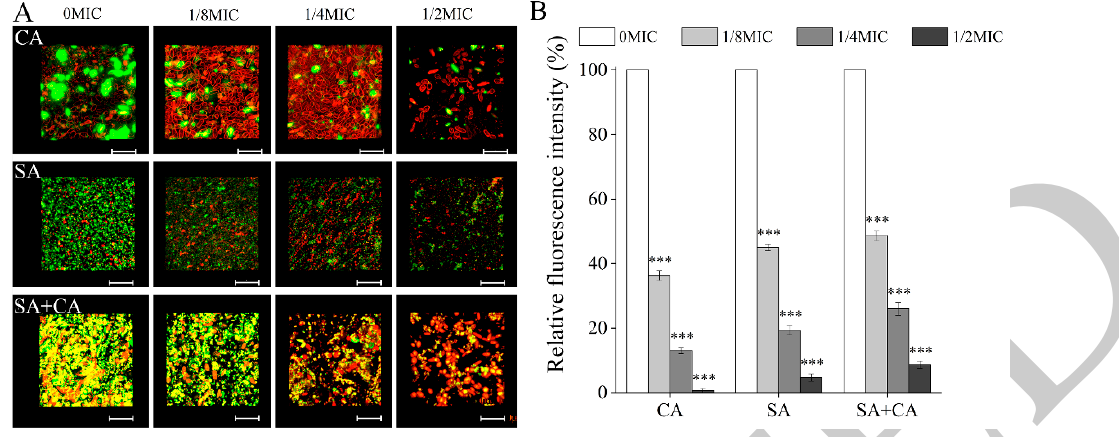
Figure 5. Effects of different concentrations of chelerythrine on the levels of extracellular polysaccharides inside C. albicans (CA) and S. aureus (SA) mono- and dual-species (SA+CA) biofilms. (A) Extracellular polysaccharides were stained with a green fluorescent stain wheat germ agglutinin, and C. albicans and S. aureus cells were labelled with a red lipophilic membrane dye FM 4-64. Scale bars represent 10 μ m. (B) The relative fluorescence intensity of extracellular polysaccharides in biofilms of each treatment group was plotted against that in untreated group by measuring green fluorescence ratios using KS 400 version 3.0 software. Bars represent the standard deviation ( n = 3). *** p < 0.001.